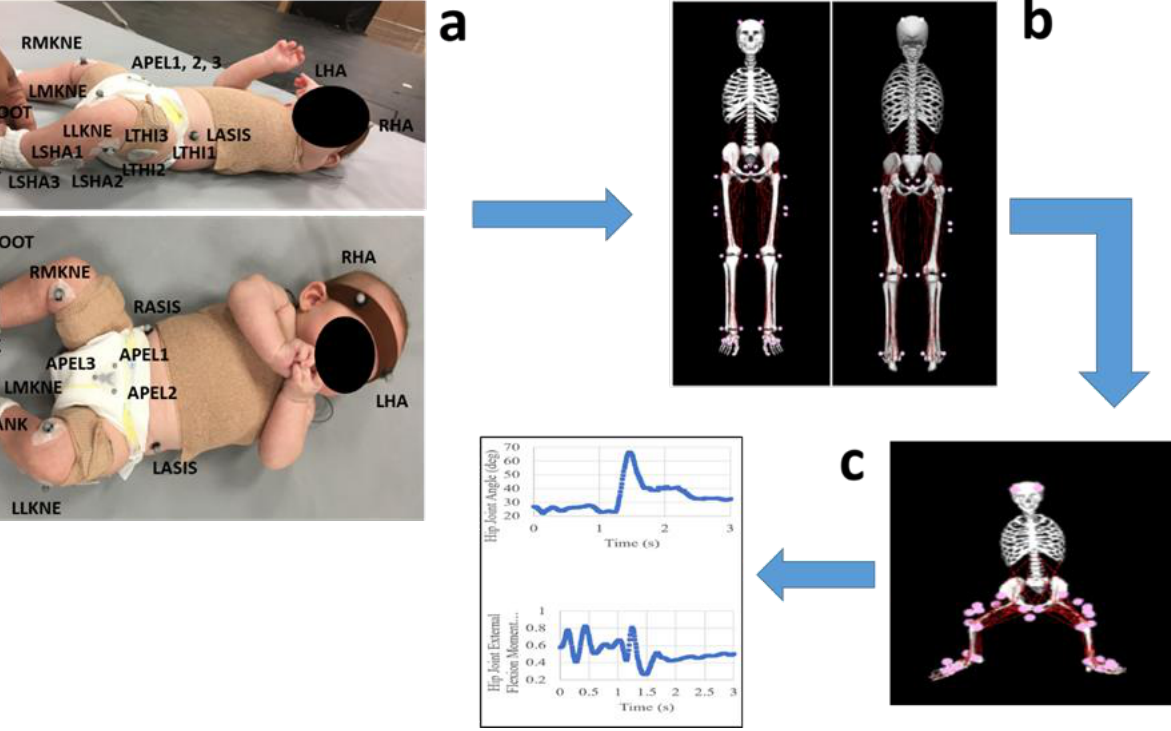
Figure 1. Methodology pipeline: ( a ) infant MOCAP data collection, ( b ) musculoskeletal scaling, and ( c ) musculoskeletal model to predict hip joint ROMs and external hip joint moments.